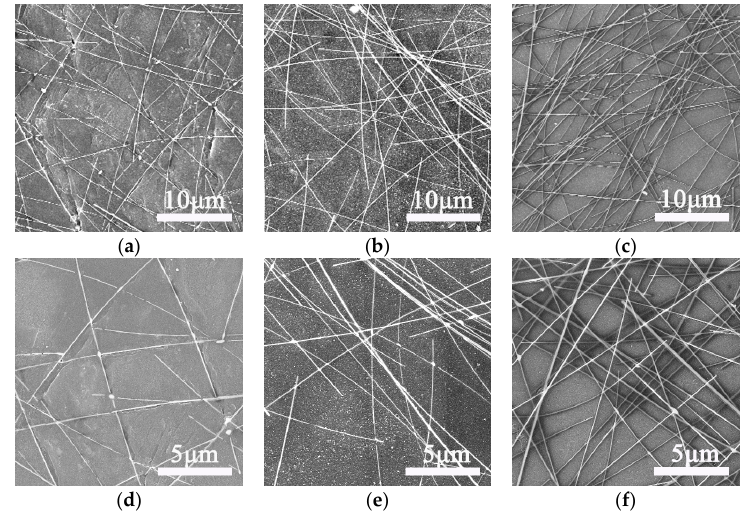
Figure 3. Low- and high-magnification SEM (scanning electron microscope) images for the Ag NW-PI transparent electrodes with transmittances of 71% ( a , d ), 67% ( b , e ) and 53% ( c , f ),